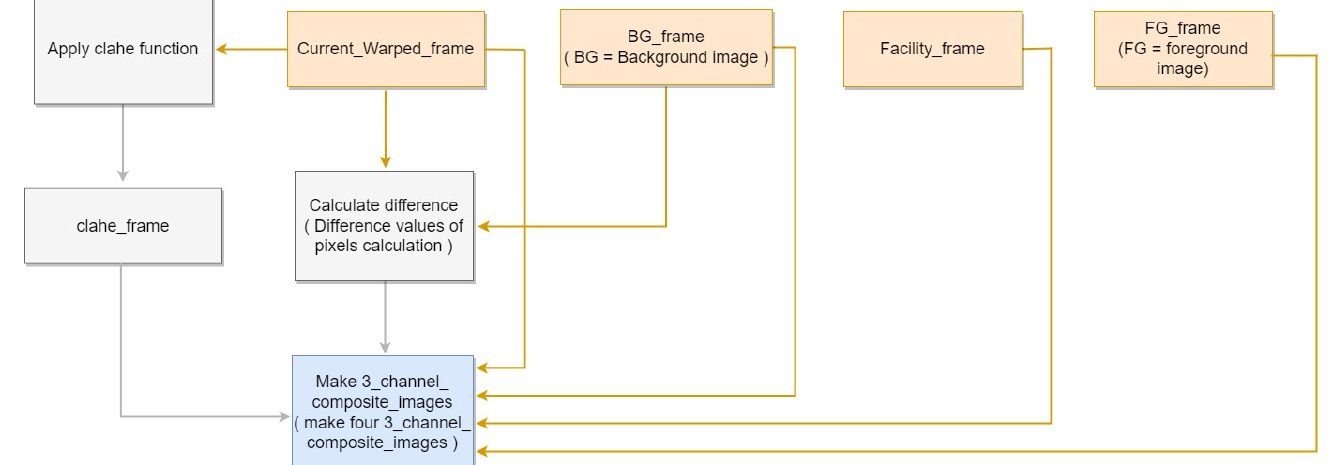
Figure 8. Composite Image Generation block diagram.